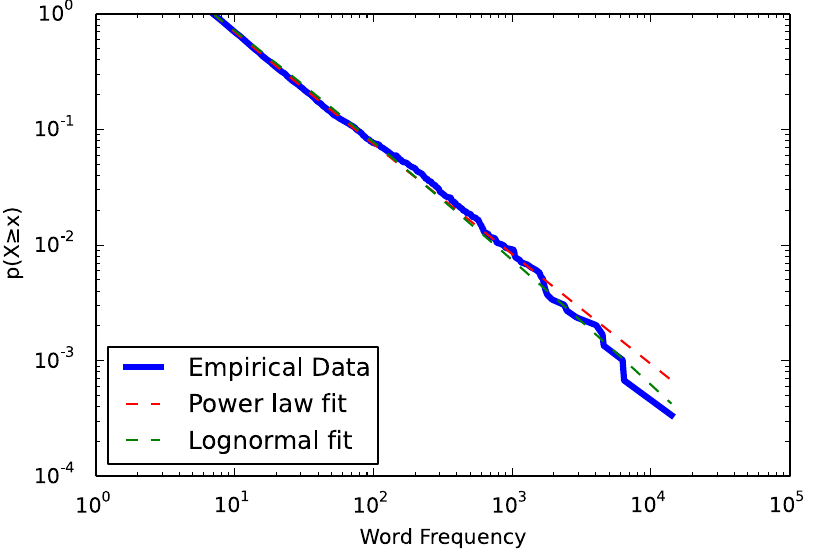
Figure 4. Complemenatary cumulative distribution functions of word frequency data and fitted power law and lognormal